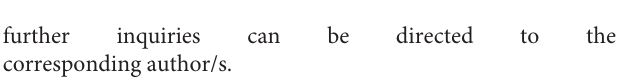
FIGURE 5 | cells were cocultured for 72h with 0.5 mg/ml plate-bound CD3 mAb. PMA + iono was added for the last 6h of culture. Depleted and undepleted B cells were surface stained with CD4 and CD19 mAbs, permeabilized, and stained with TNF- α or IFN- γ mAbs. (A) Representative flow cytometry plots for IFN- γ + and TNF- α + CD4 + T cells in MG patients and healthy controls according to whether CD19 + CD38 hi CD24 hi B cells were depleted or undepleted. (B) Graphs showing the differences in the frequency of IFN- γ + CD4 + and TNF- α + CD4 + T cells between depleted and undepleted B cells from the same individual. Healthy individuals are indicated by white squares, and MGs are indicated by black triangles. The results from three healthy individuals and three MG patients are shown. * p < 0.05, ** p < 0.01. (C) Representative histograms of pSTAT-3 expression by CD19 + CD24 hi CD38 hi , CD19 + CD24 int CD38 int , and CD19 + CD24 + CD38 − B cells at 0 and 15min post-stimulation with CD40 mAb for one MG patient and one healthy